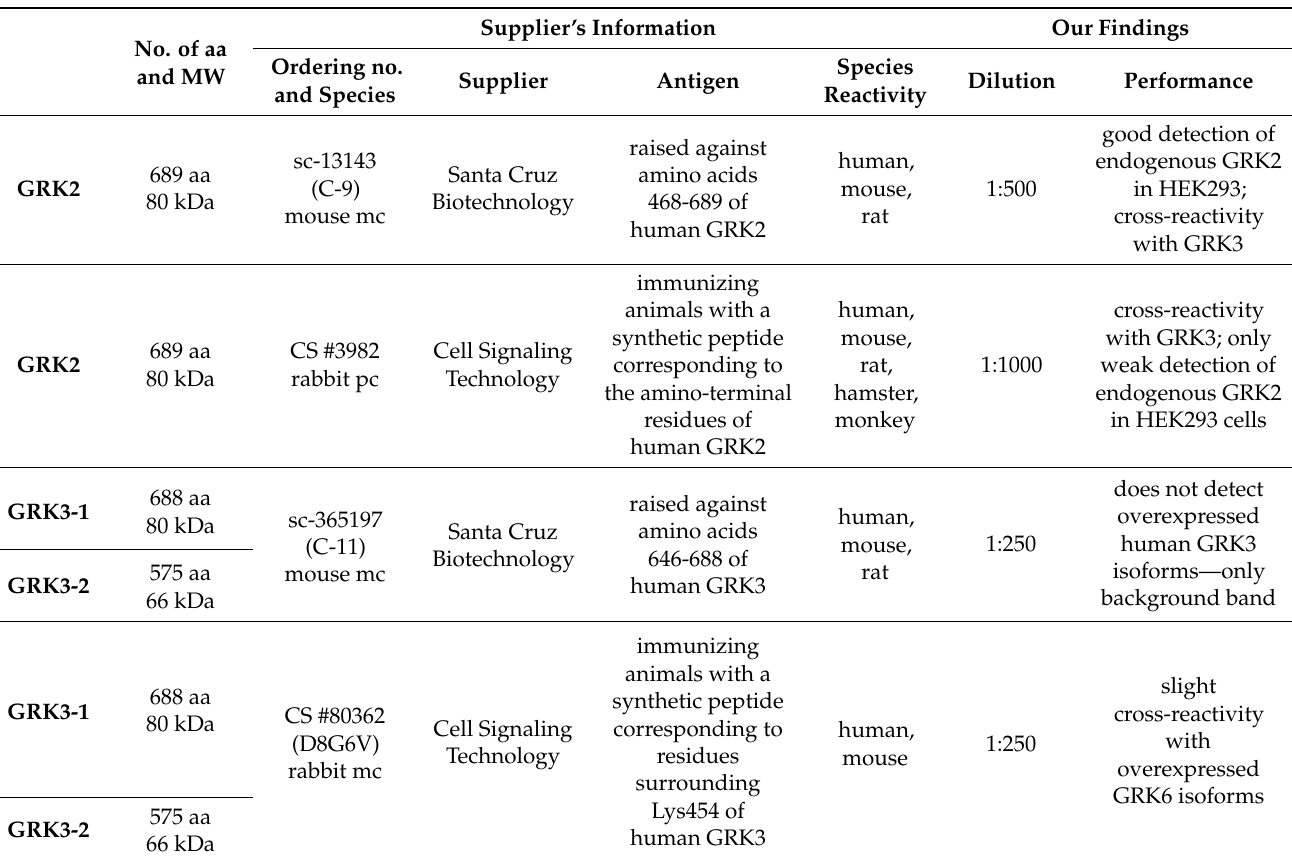
Table 1. List of eight commercially available antibodies examined in this study, targeting the ubiq- uitously expressed human GRK isoforms. Overview of the tested antibodies (monoclonal (mc), polyclonal (pc)) and the tested GRK isoform is provided, including the supplier’s information, our review of each antibody, and the dilution used in Western blot to determine the antibody specificity. Additionally, the number of amino acids (aa) and the calculated approximate molecular weight (MW) for each human GRK isoform are listed. Accession numbers for protein isoforms can be found in the Materials and Methods section and additionally summarized in Supplementary Table